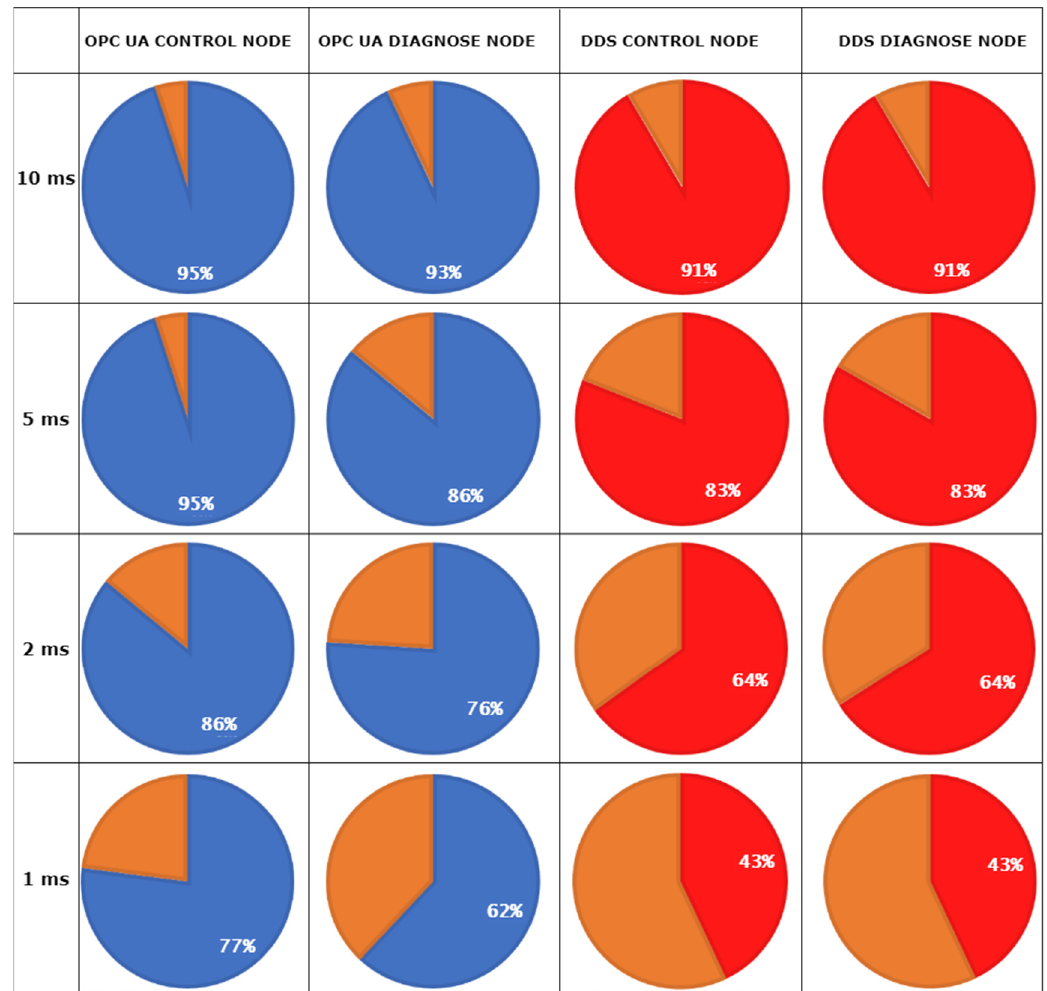
Figure 4. Data-buffering success rate percent-based results.